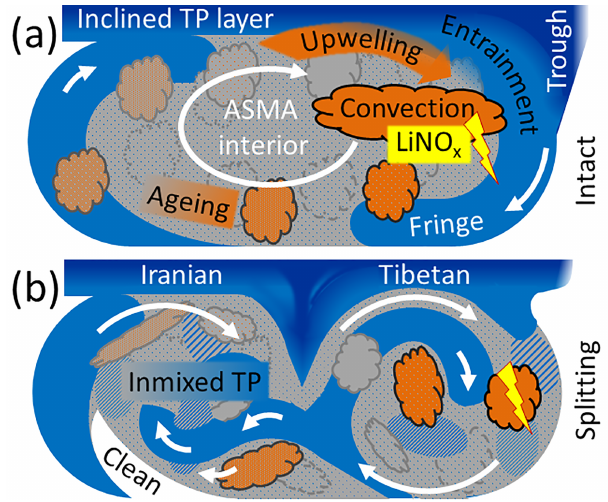
Figure 14. Schematic of processes determining trace gas distribu- tions in the ASMA at a UT level: (a) One undisturbed anticyclone, encompassing the Tibetan and Iranian regions. (b) Splitting into an Iranian and a Tibetan part. See text for